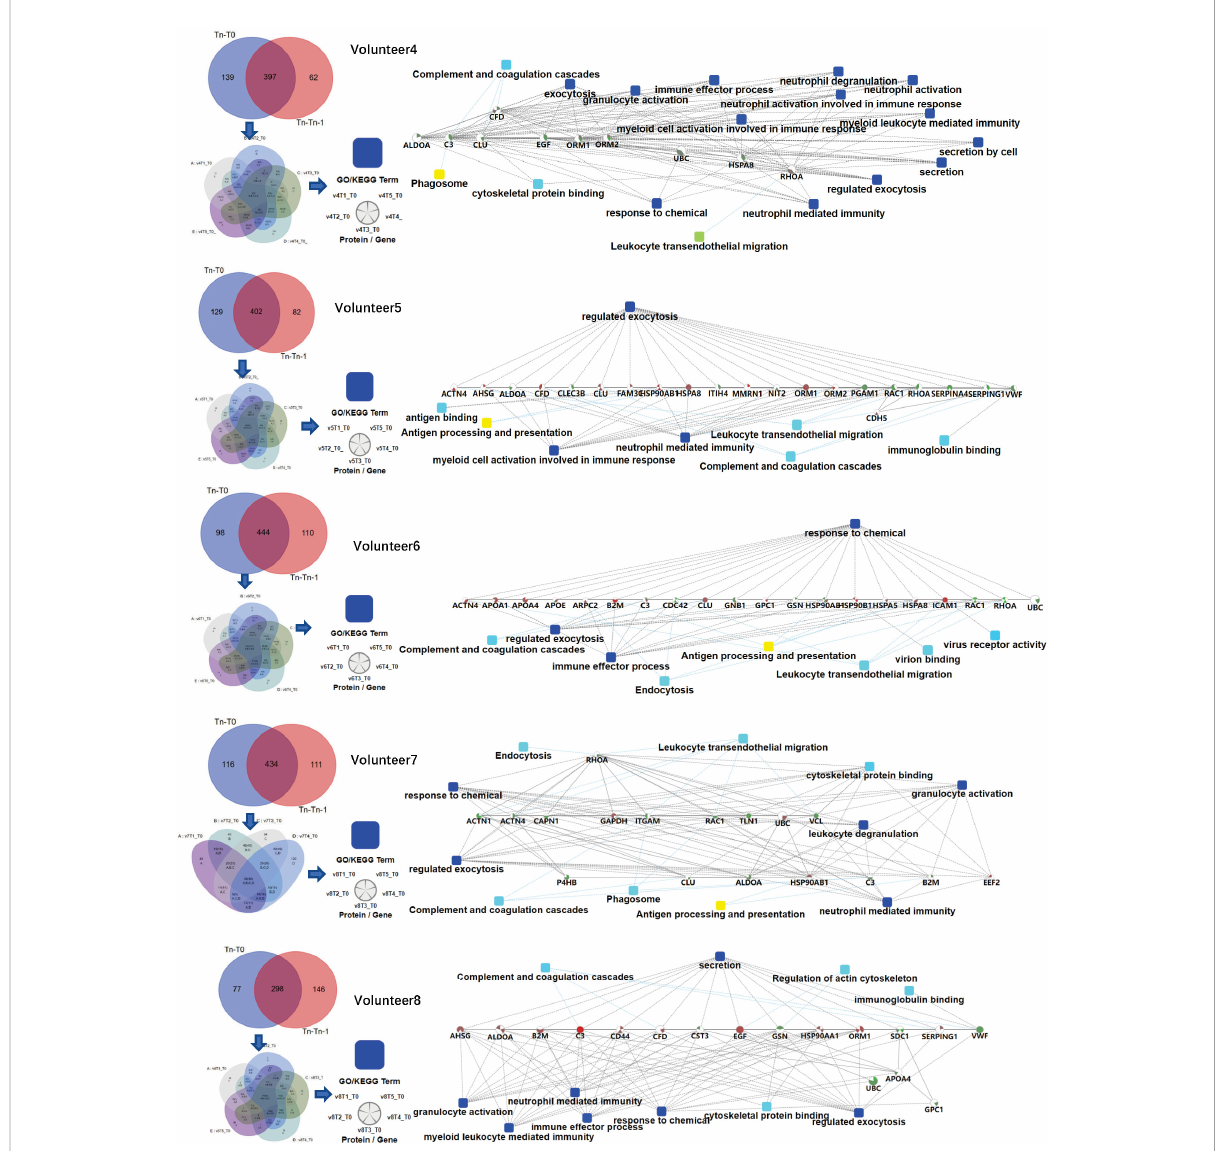
FIGURE 2 Differences in the immune response of each volunteer after QIV vaccination. (A) Total immune-related BP (p-value< 0.05) of everyone by DAVID. The differential proteins(fold change > 2 or< 0.5, p-value<0.05) were obtained by self-contrasted method individually (comparison including: T1-T0, T2-T0, T3-T0, T4-T0, T5-T0; T1-T0, T2-T1, T3-T2, T4-T3, T5-T4). (B) Signi fi cantly changed proteins (fold change > 2 or< 0.5, p-value<0.05) in T1 compared T0 was enriched by omicsbean, and their up/down-regulate and PPI were different. Network nodes and edges represent proteins and protein – protein associations. Green/red solid lines represent inhibition/activation; gray dotted lines represent GO pathways. Color bar from red to green represents the fold change of protein level from increasing to decreasing. The signi fi cance of the pathways represented by − log(p value) (Fisher ’ s exact test) was shown by color scales with dark blue as most signi fi cant. (C) Venn diagram of the signi fi cantly changed proteins (fold change > 2 or< 0.5, p-value<0.05) obtained by the two comparison methods at all different time points for each vaccine recipients. The proteins and their fold change to obtain the overall immune system pro fi le of each person by STRING and omicsbean. These pathway p-value were